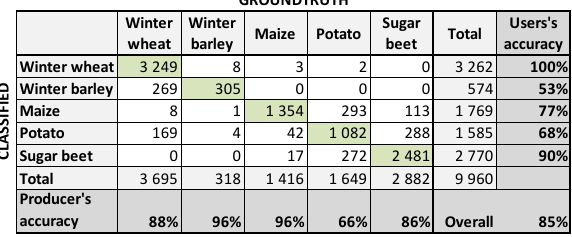
Table 2. Confusion matrix based on the comparison of in-situ-mapped and modelled land cover